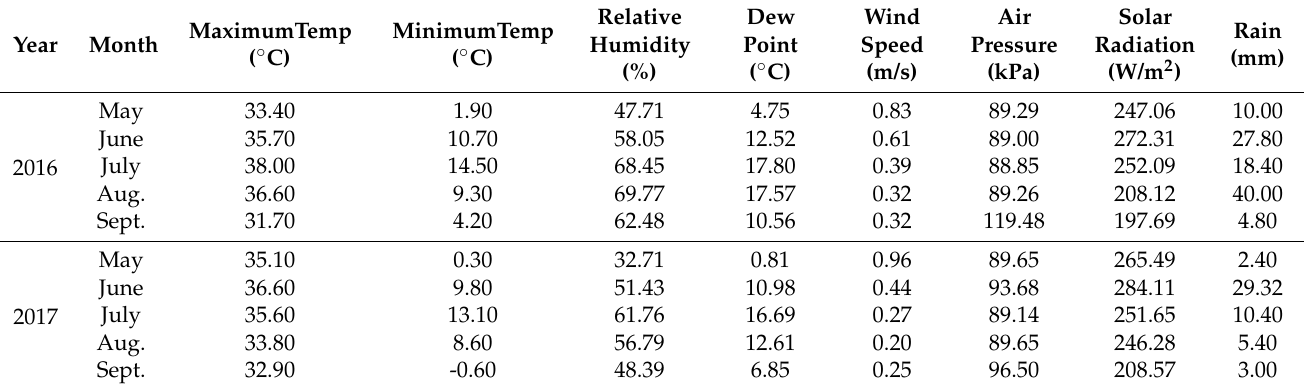
Table 1. Monthly meteorological data during the crop growth